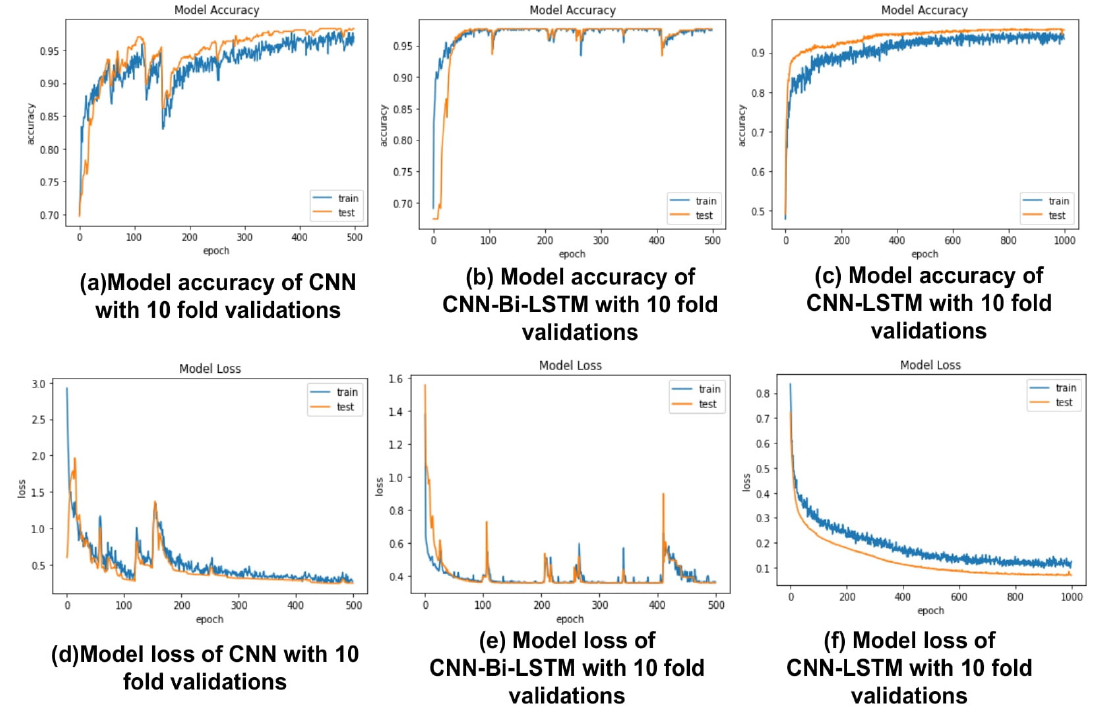
Figure 11. ( a ) Model accuracy of CNN with 10-fold cross-validation. ( b ) Model accuracy of optimized proposed model (CNN-Bi-LSTM). ( c ) Model accuracy of CNN-LSTM model. ( d ) Model loss of CNN. ( e ) Model loss of proposed model. ( f ) Model loss of CNN-LSTM. Table 11. Validation of proposed model with K-fold cross-validation without filling missing values. Precision Recall F1-Score